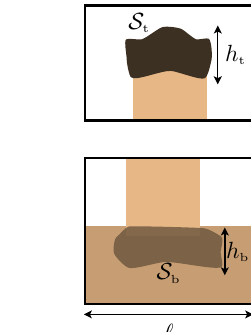
, and thickness P able to L = ϕ h t t S t